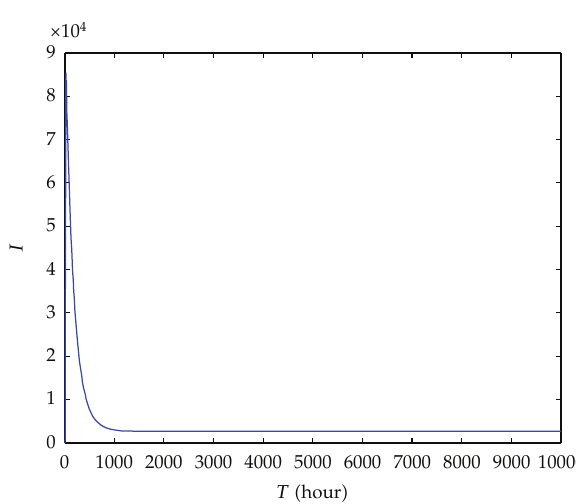
Figure 6: The virus propagation result when f < f e .